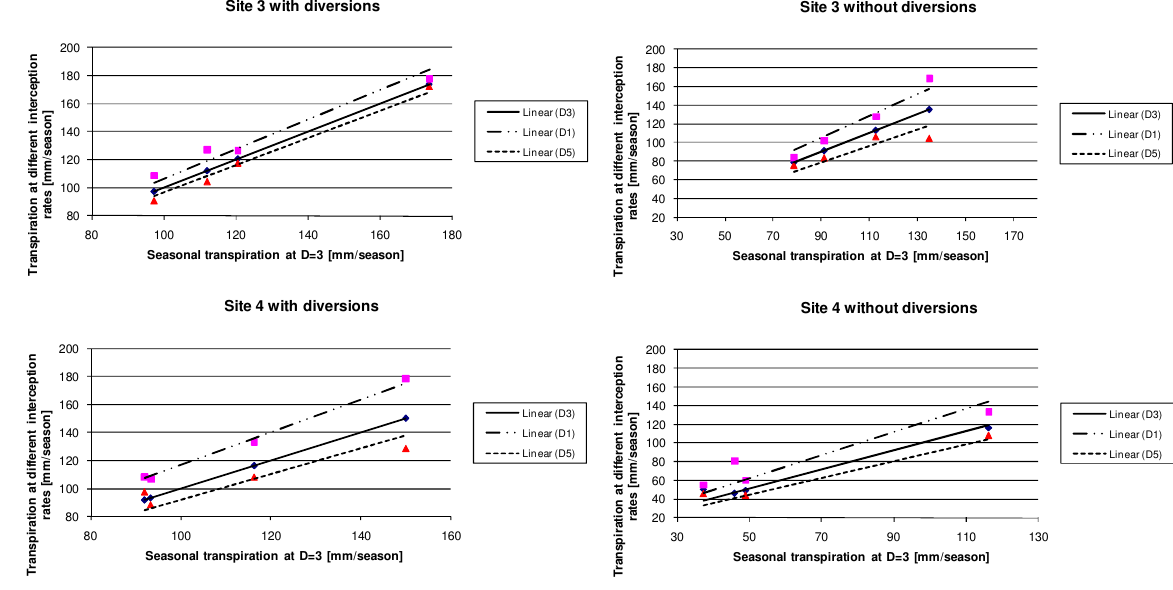
Figure 6: Comparison of seasonal transpiration values for different interception thresholds.